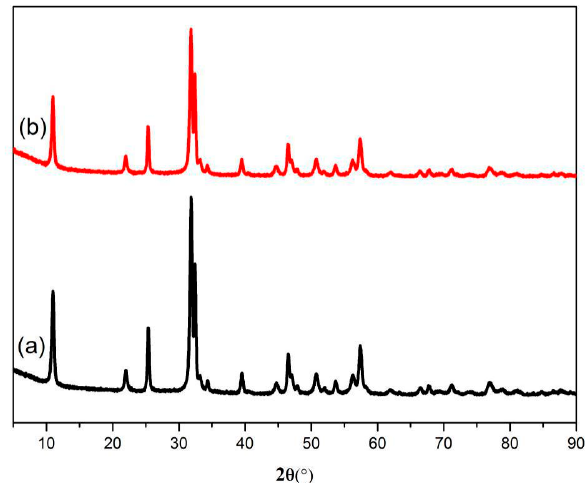
Nanomaterials 2019 , 9 , x FOR PEER REVIEW Figure 8. XRD patterns of ( a ) BOB / SFO-5 and ( b ) recovered BOB / SFO-5. Figure 8. XRD patterns of ( a ) BOB/SFO-5 and ( b ) recovered BOB/SFO-5. Figure 8. XRD patterns of ( a ) BOB/SFO-5 and ( b ) recovered BOB/SFO-5.